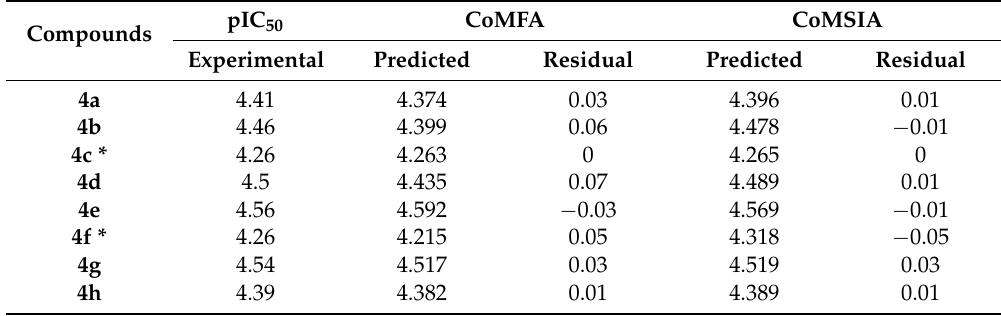
Table 3. The actual and predicated pIC 50 values with their residuals of the training and test set compounds generated by CoMFA-3a and CoMSIA-1a